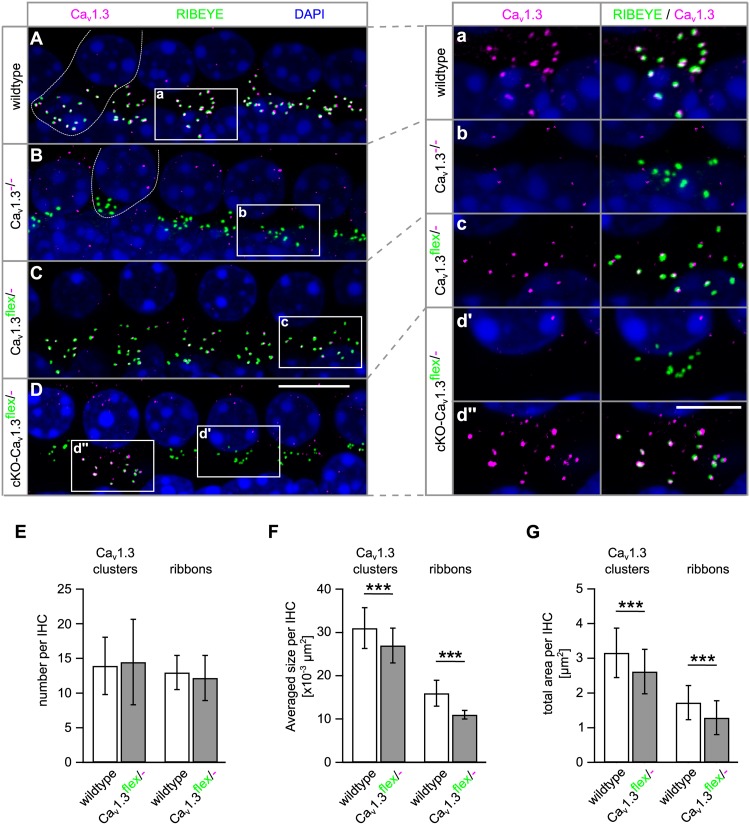
Presynaptic Cav1.3 clusters are missing at the IHC synapse of cKO-Cav1.3flex/- mice and are smaller at IHC synapses of Cav1.3flex/- control mice. (A–D) MIP of confocal stacks of whole-mount preparations of apical turn organs of Corti co-immunolabeled for Cav1.3 and RIBEYE at 4 weeks of age. Stretches with four to five IHCs of a wildtype (A), a Cav1.3-/-
(B), a Cav1.3flex/- control (C) and a cKO-Cav1.3flex/- mouse (D) labeled with anti-Cav1.3 (magenta) and anti- RIBEYE (green) are shown, with one wildtype and one Cav1.3-/- IHC indicated by a dashed line in panels (A) and (B). (a–d″) Enlarged synaptic poles of IHCs from boxes in panels (A–D) shown with split color channels and as merge. (E–G) Quantitative analysis of the Cav1.3 clusters and RIBEYE-labeled ribbons in IHCs of Cav1.3flex/- control and wildtype mice. (E) Number of Cav1.3 clusters (P = 0.69) and ribbons per IHC (P = 0.074) were unaffected in Cav1.3flex/- control mice (MWU test). (F) Average sizes per IHC of both, Cav1.3 clusters and ribbons were reduced in Cav1.3flex/- control mice (∗∗∗P < 0.001, MWU test). (G) This reduction also applied to the total area of Cav1.3 clusters and of ribbons per IHC in Cav1.3flex/- control mice (∗∗∗P < 0.001, Student’s t-test). Number of ears/animals/images analyzed (with eight IHCs per image), respectively: wildtype, 4/2/56; Cav1.3flex/- control mice: 5/3/100; scale bars: (A–D), 10 μm; (a–d″), 5 μm.